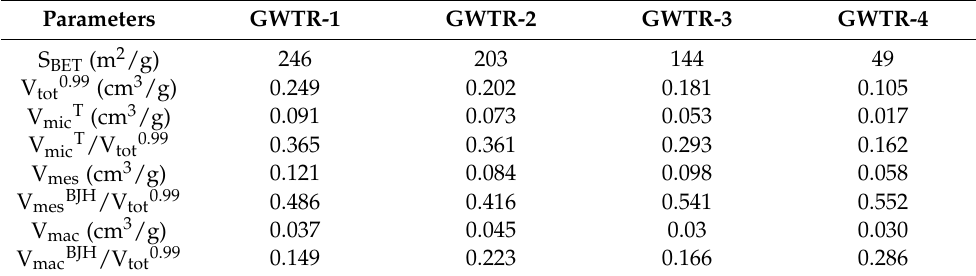
Figure 4. Comparison of N 2 adsorption and desorption isotherms at − 196 ◦ C for ( a ) GWTR-1, ( b ) GWTR-2, ( c ) GWTR-3, ( d ) GWTR-4. Table 3. Textural parameters of